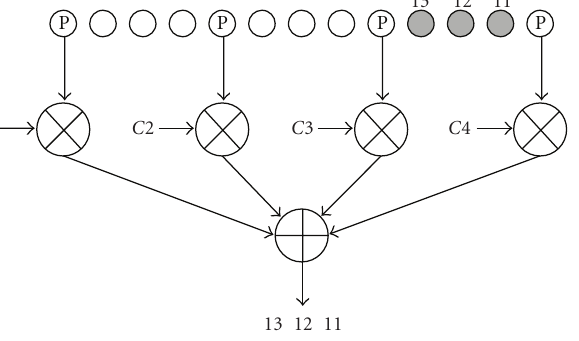
Figure 9: 4-tap FIR filter for SPLINE interpolation. Table 3: OFDM system parameters.